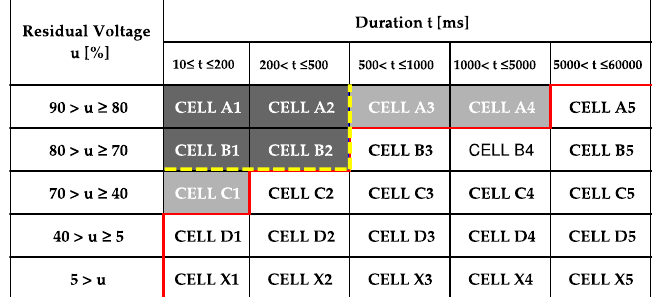
Figure 11. CEI EN 50,160 Voltage Dips classification and thresholds for N2a (dashed-yellow line) and N3b (continuous-red line) severe events counting indices.